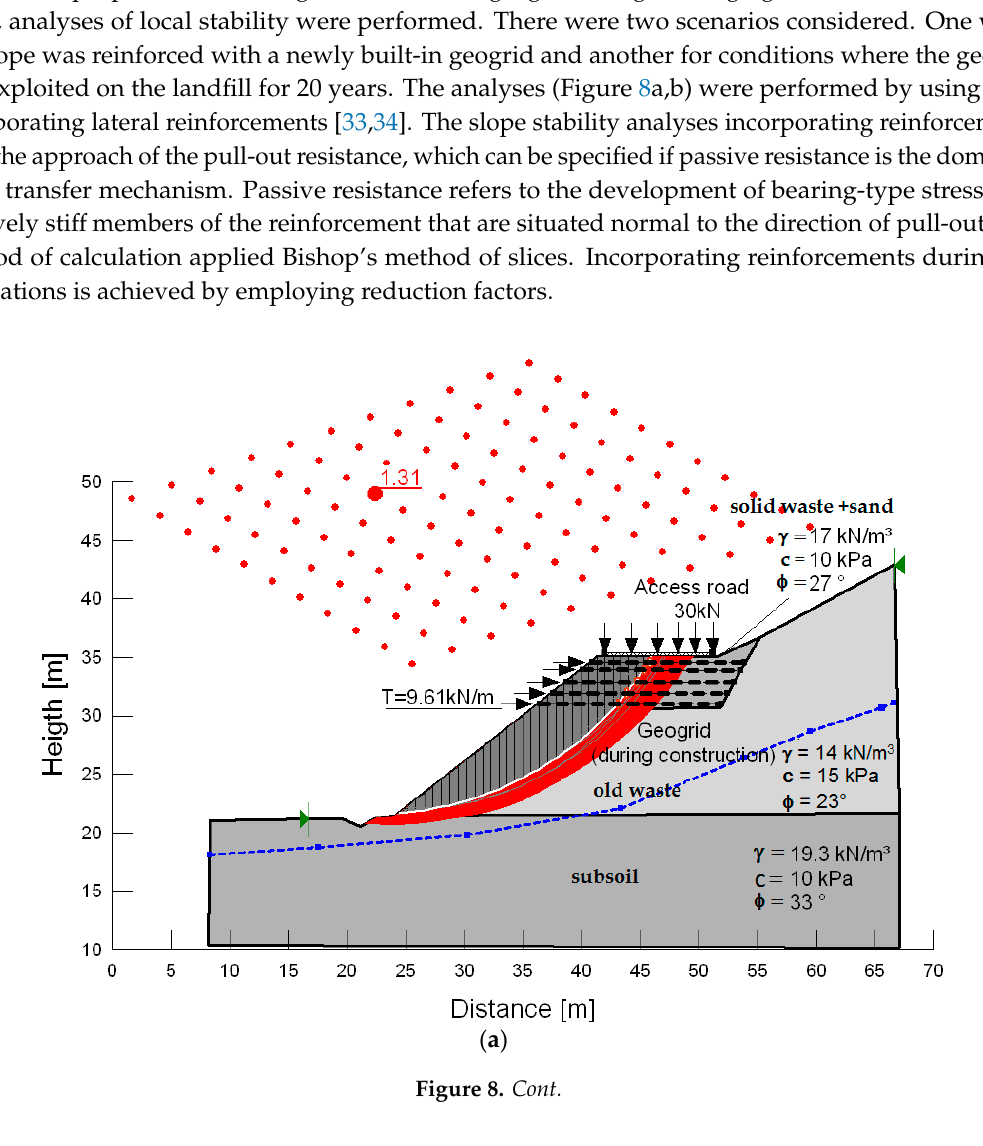
( b ) Figure 8. Slope stability analyses for ( a ) newly built geogrid of nominal tensile strength of 9.61 kN/m, and ( b ) geogrid after 20 years (measured tensile strength of 42.63 kN/m). 4. Conclusions The characteristics of a landfill structure and the long-term process of reclamation create suitable conditions for application of the observational method. The monitoring and displacement analyses, and determination of the geotechnical parameters of waste material, allow successful application of such an approach especially in the safety management of such demanding sites. The proposed method was used here to expand the volume of the landfill and the exploitation time. The engineering works at the site allowed the volume of the landfill to be extended by as much as 800,000 m 3 , which increased the capacity to a further 7 years for waste disposal at the site. The study